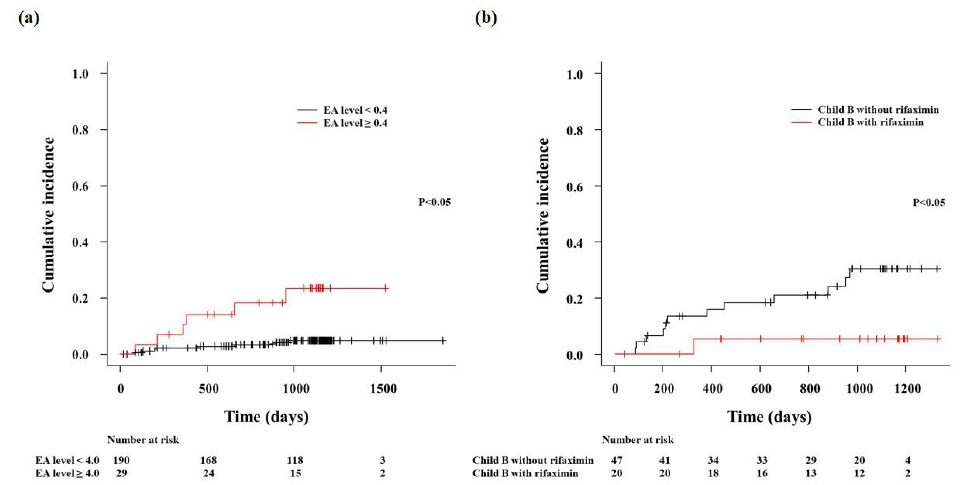
Figure 2. Cumulative incidence of ACLF. ( a )The risk of ACLF development was significantly higher ( p < 0.05) in patients with high EA (≥0.4) than in those with low EA (<0.4). ( b ) The risk of ACLF development was significantly lower in Child – Pugh B patients who were treated with rifaximin than in those without treatment ( p < 0.05). EA, endotoxin activity; ACLF, acute-on-chronic liver